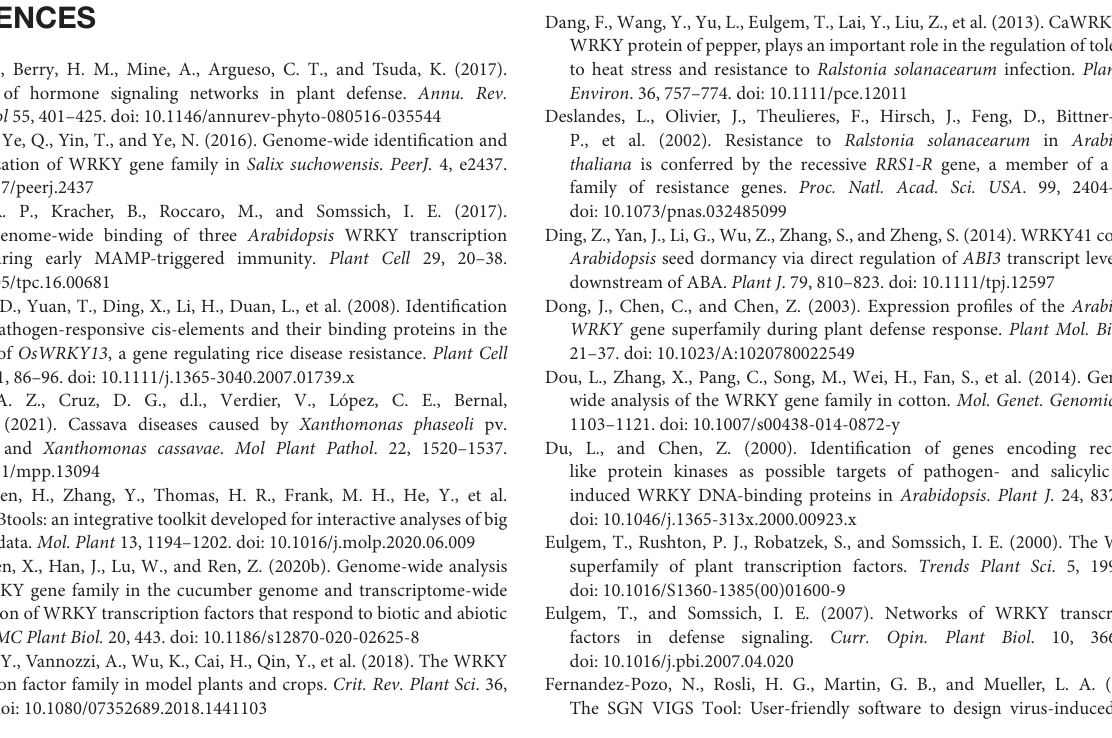
Supplementary Figure 3 | Multiple sequence alignment of the WRKY domain among cassava MeWRKYs and selected AtWRKYs. A total of seven different Arabidopsis WRKY proteins from each of the groups or subgroups were randomly selected as representatives for the further comparison. For group I WRKY proteins, “N” and “C” indicated the N-terminal and C-terminal WRKY domains of a specific WRKY protein, respectively. The typical amino acid residues within WRKY domain and zinc-finger motif were in red and blue color, respectively. The conserved introns were indicated by arrowhead. Supplementary Figure 4 | Multiple sequence alignment of cassava WRKY IIa members. Supplementary Figure 5 | Expression profiles of cassava WRKYs in leaves and roots of Argentina 7 (Arg7), wild subspecies (W14), and Kasetsart University 50 (KU50). Supplementary Figure 6 | VIGS phenotype of cassava leaves. (A) Silencing phenotypes on cassava leaves at 30 dpi using CsCMV VIGS system. pCsCMV- ChlI 345 was used as positive control. (B) RT-qPCR analyses of target gene expression levels in VIGS plants. Supplementary Table 1 | Primers used in this study. Supplementary Table 2 | Transcriptome datasets used for expression and WGCNA analysis. Supplementary Table 3 | The detailed information of MeWRKY genes identified in the cassava genome. Supplementary Table 4 | Gene duplication events of MeWRKYs . Supplementary Table 5 | Sequence logos of the conserved motifs in cassava WRKY proteins. Supplementary Table 6 | Summary of the annotation for 156 cassava genes containing W-box in their 2-kb promoter region. Supplementary Table 7 | Genes belong to different co-expression modules built from co-expression